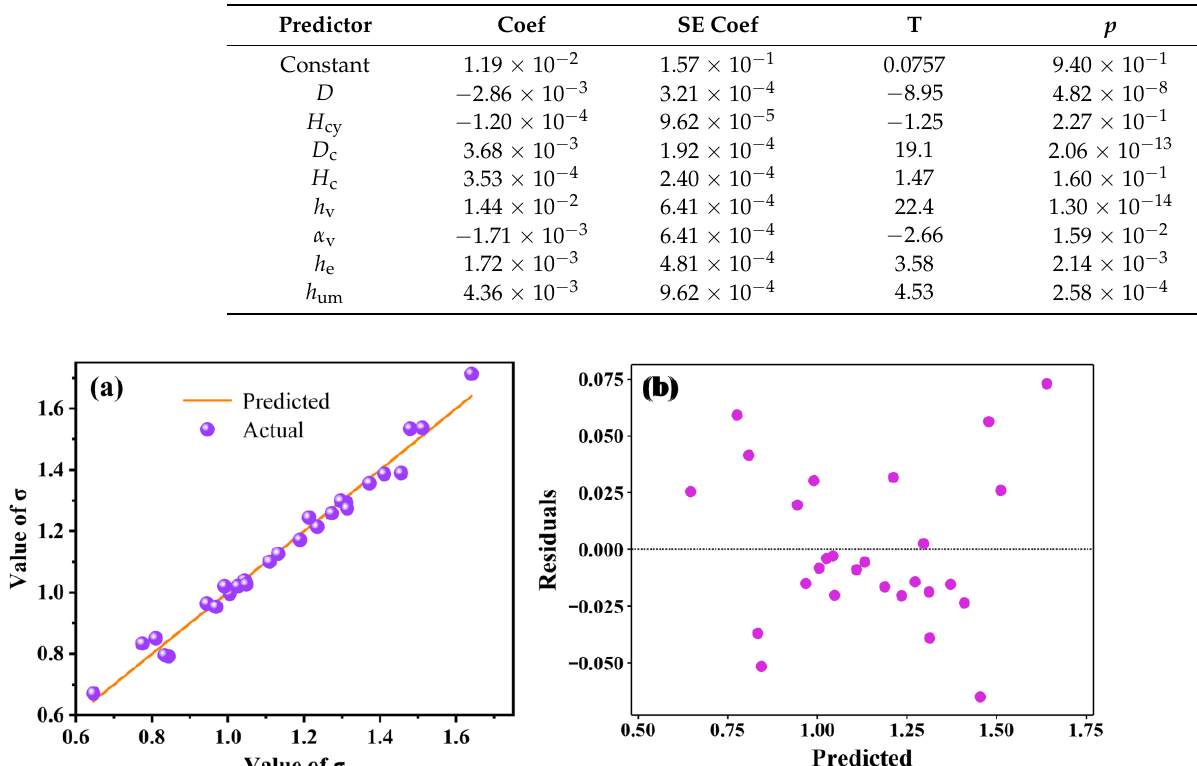
Table 11. Regression analysis for factors on σ .